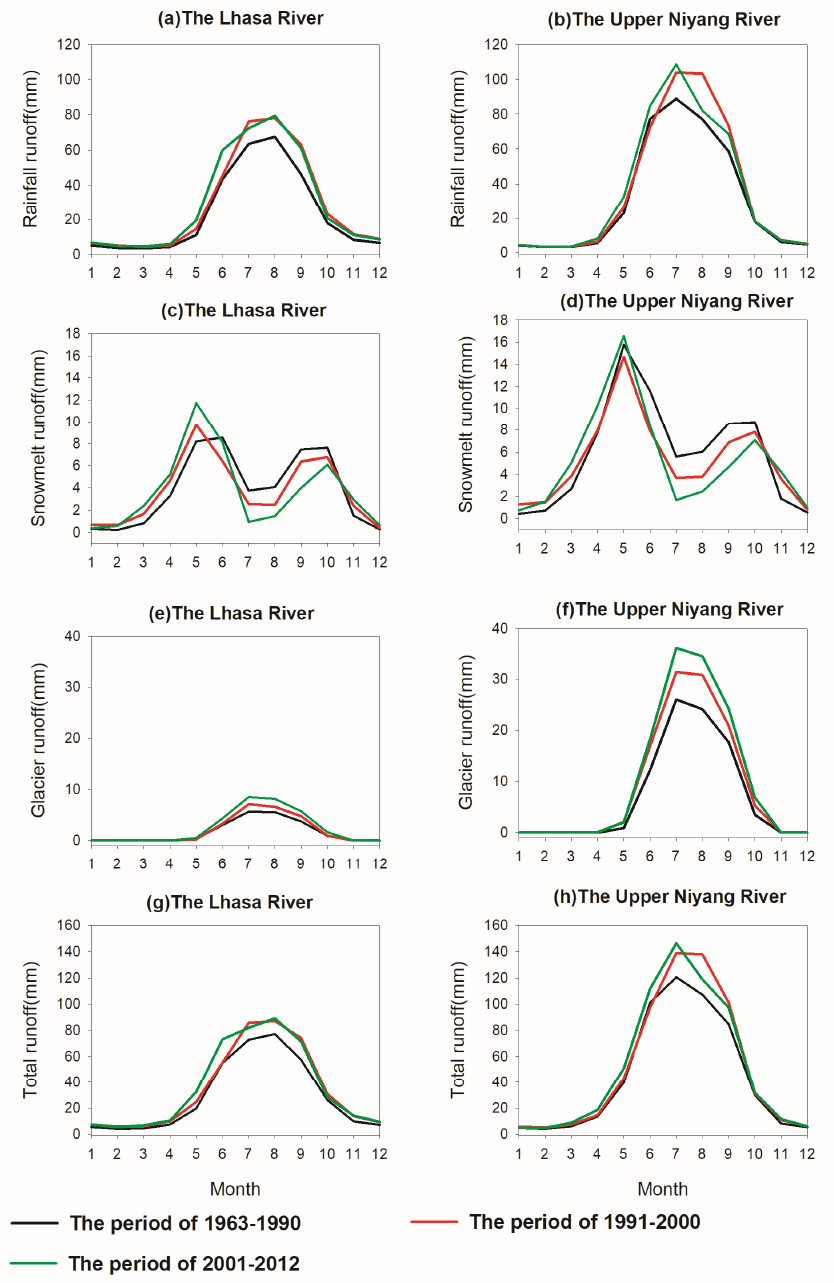
Figure 10. Mean monthly rainfall runoff, snowmelt runoff, glacier runoff and total runoff during the reference period (1963–1990), 1990s (1991–2000), and 2000s (2001–2012) over two study basins.